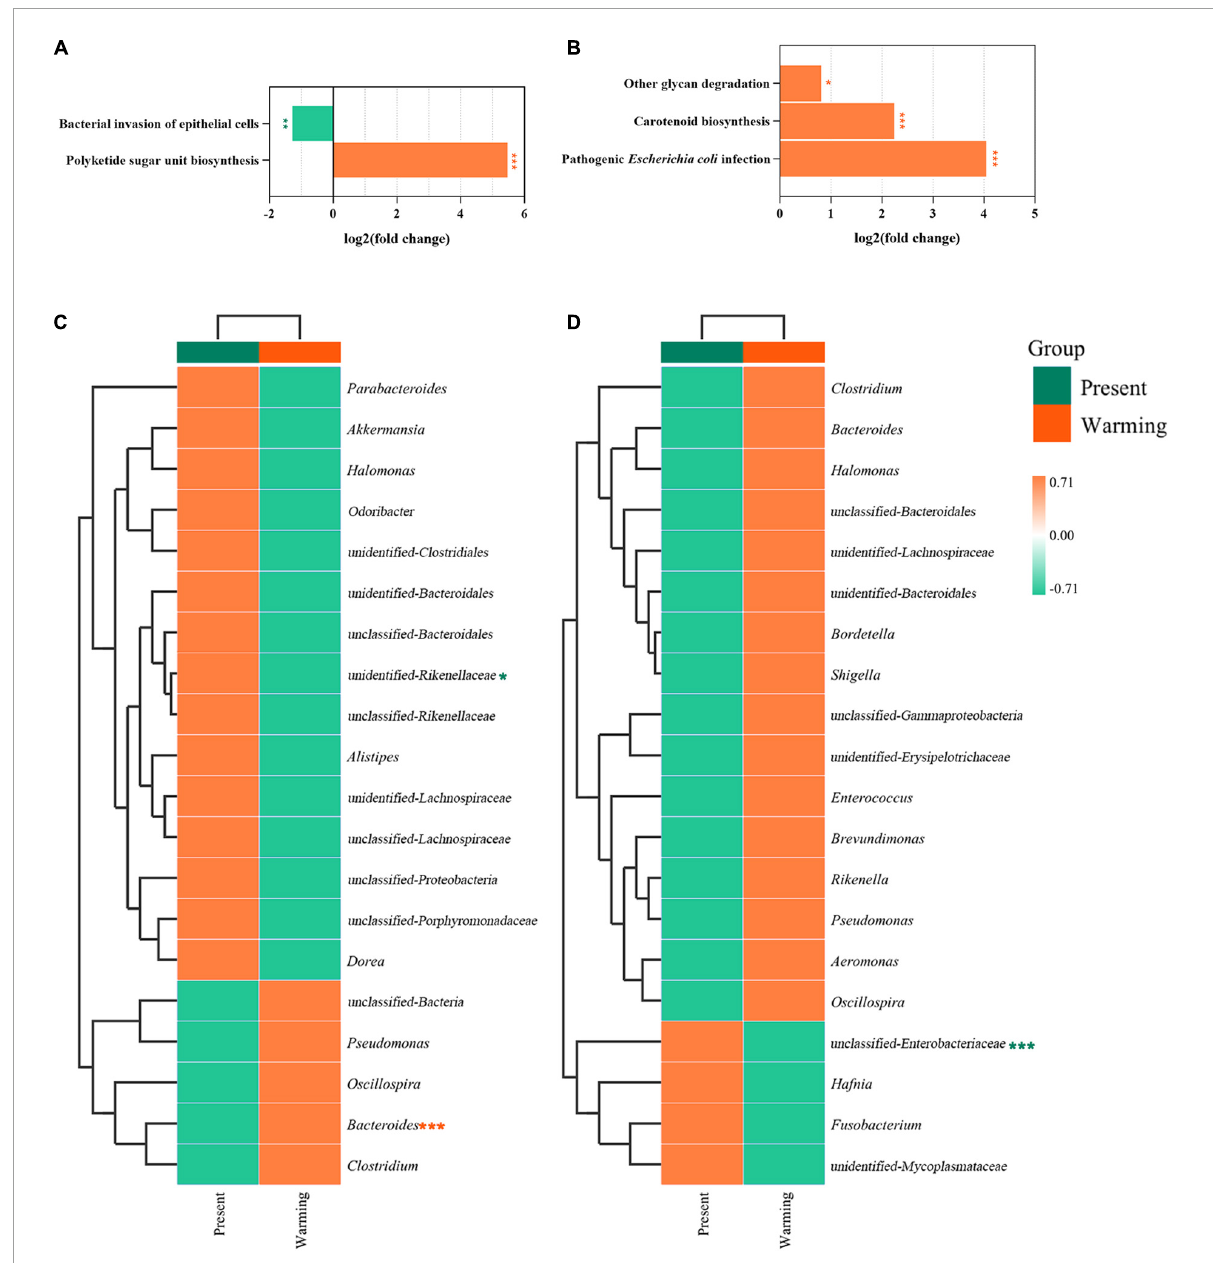
FIGURE7 Functionally predicted KEGG pathways and the hierarchical clustering heatmap of species contribution composition of differential pathways between present and warming in Eremias argus (A,C) and Takydromus amurensis (B,D) , respectively. The horizontal ordinate represents the sample information and species annotation information; the cluster trees on the left and the top are species clustering and sample clustering, respectively. Present and warming indicate present and warming climate conditions, respectively. The highlighted pathways were significantly up-regulation (orange color) or down-regulation (green color) of warming climate against the present climate, respectively (* P < 0.05; ** P < 0.01; and *** P <